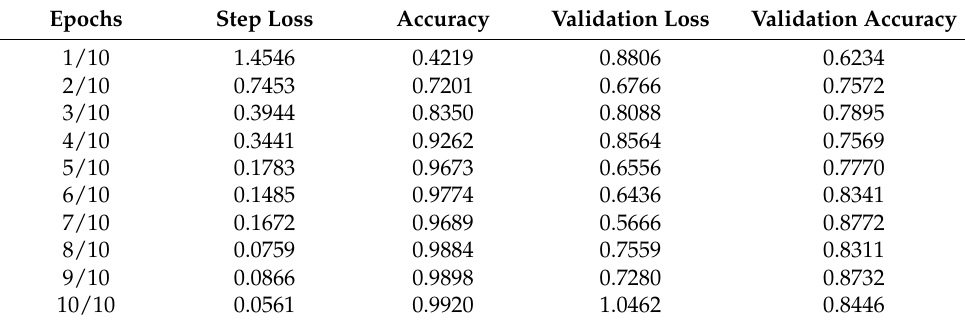
Table 2. Prescriptive data analysis for Conv2D DenseNet model compilation.